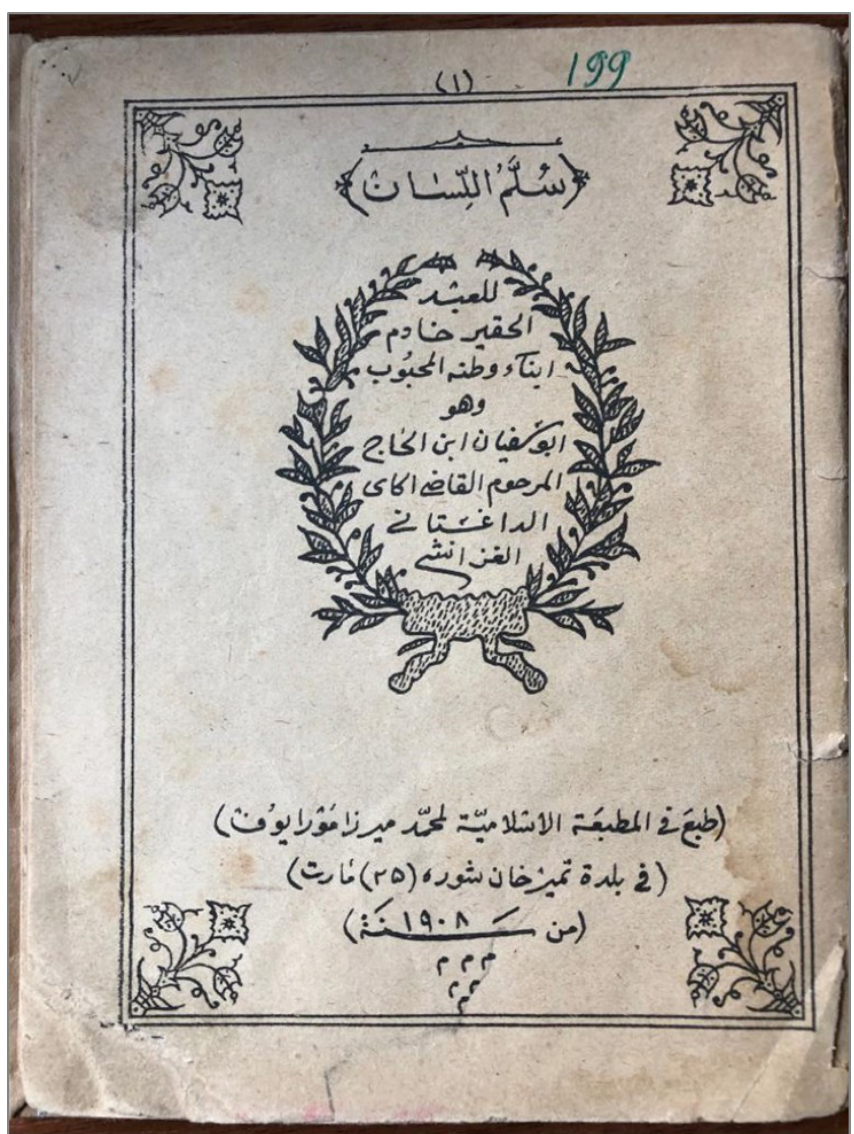
Figure 3 - The four-language dictionary "Sullam al-lisan" ("Ladder of language